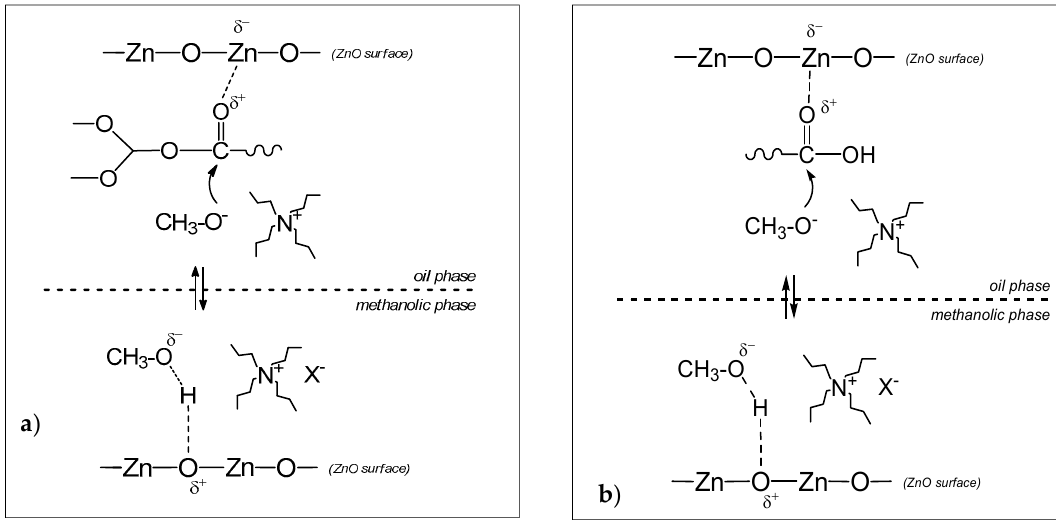
Figure 2. Schematic representation of ZnO/IL catalyst action in ( a ) transesterification of triglycerides and ( b ) esterification of fatty acids.